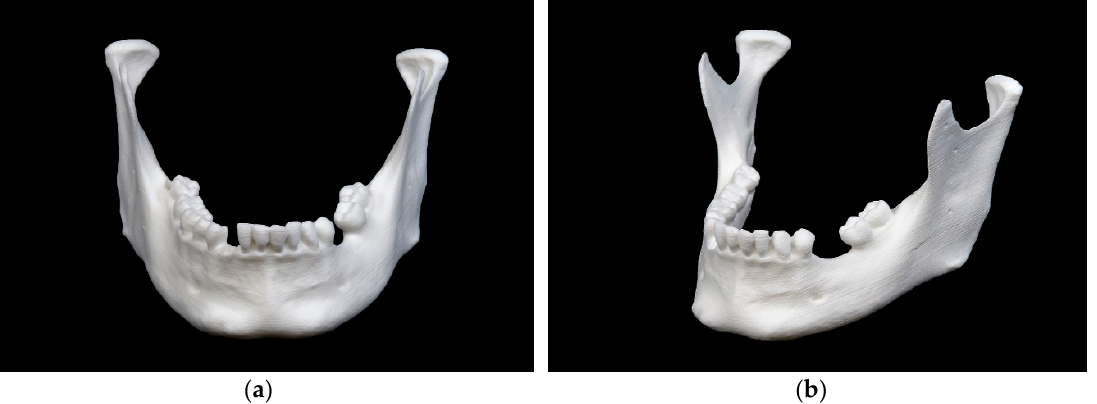
Figure 5. Mandibular model printed in selective laser sintering (SLS) technology: ( a ) front view; ( b ) side view.